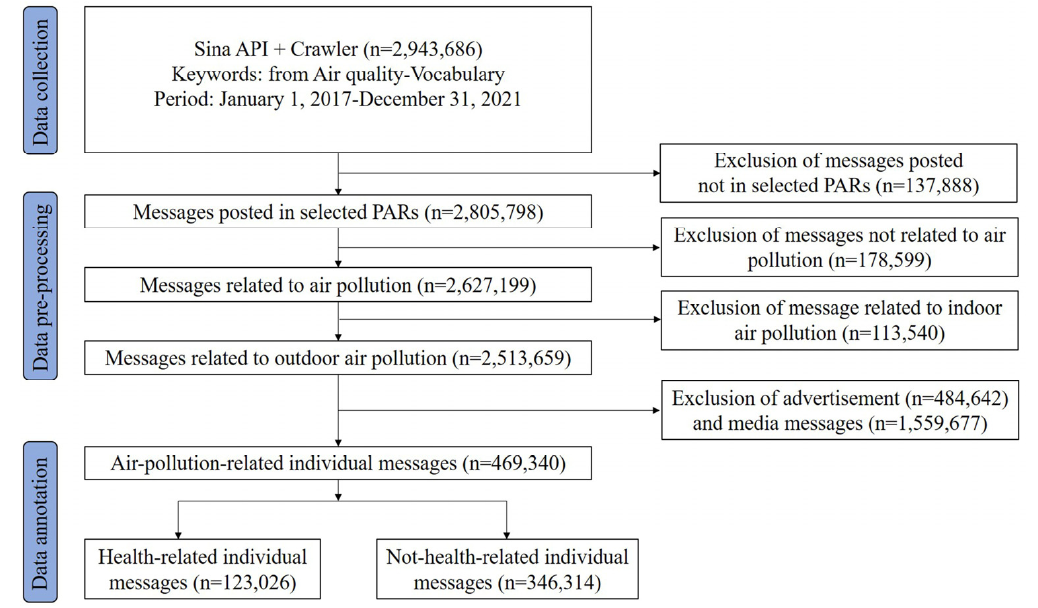
Figure 1. Flow diagram of data processing .